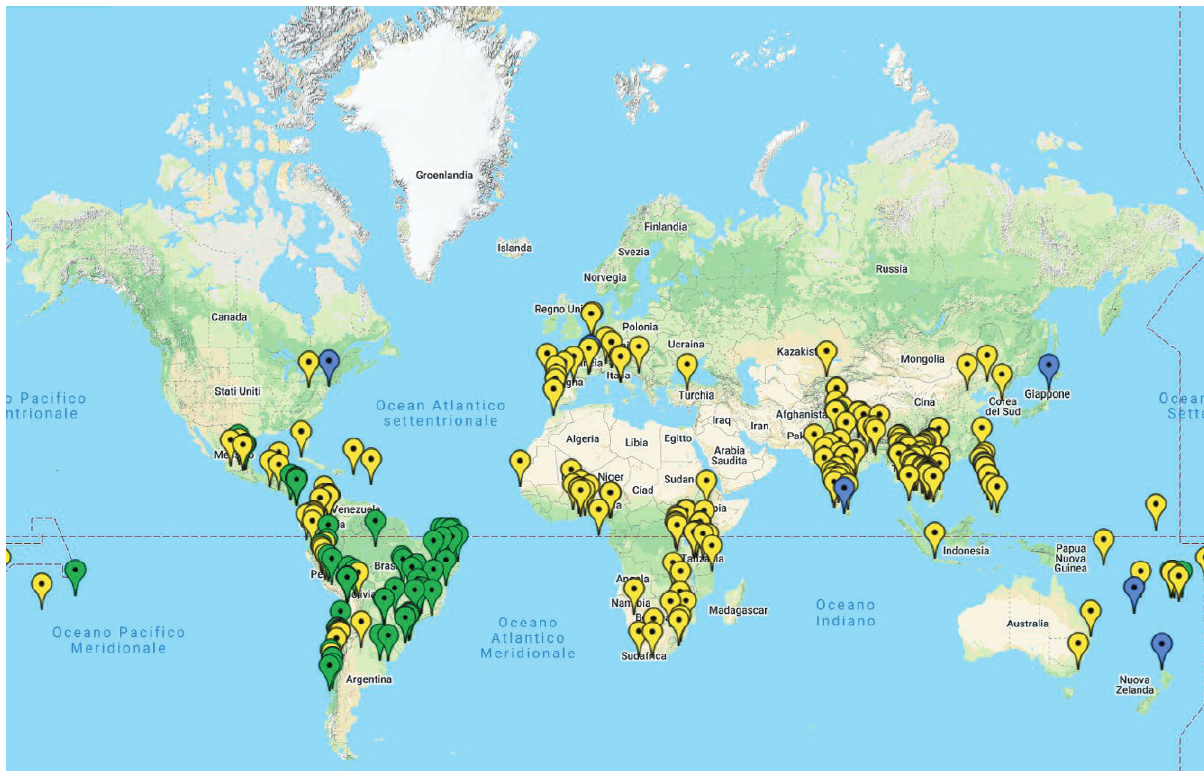
Figure 1. Worldwide PGS distribution. Source: IFOAM website